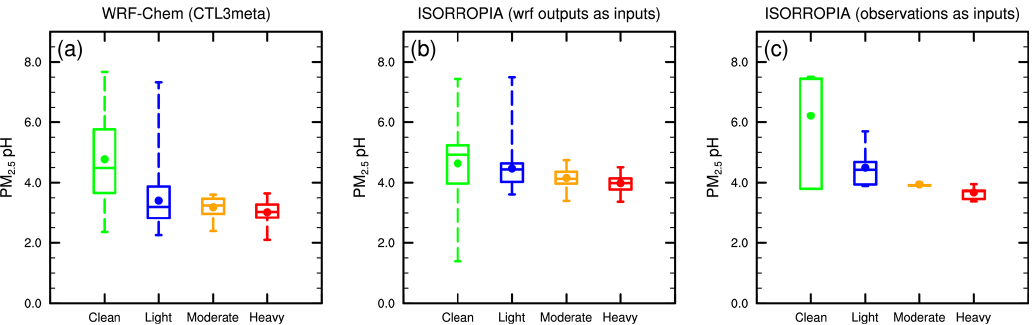
Figure 8. The box-and-whisker plots of surface PM 2 . 5 pH during each haze stage in Beijing from (a) WRF-Chem CTL3meta scenario, (b) ISORROPIA predictions with WRF-Chem (CTL3meta) relevant outputs as inputs, and (c) ISORROPIA predictions with observations as inputs. The boxes represent, from top to bottom, the 75th, 50th, and 25th percentiles of statistical data. The whiskers represent, from top to bottom, the minimum and the maximum, and the solid circles represent the mean values.